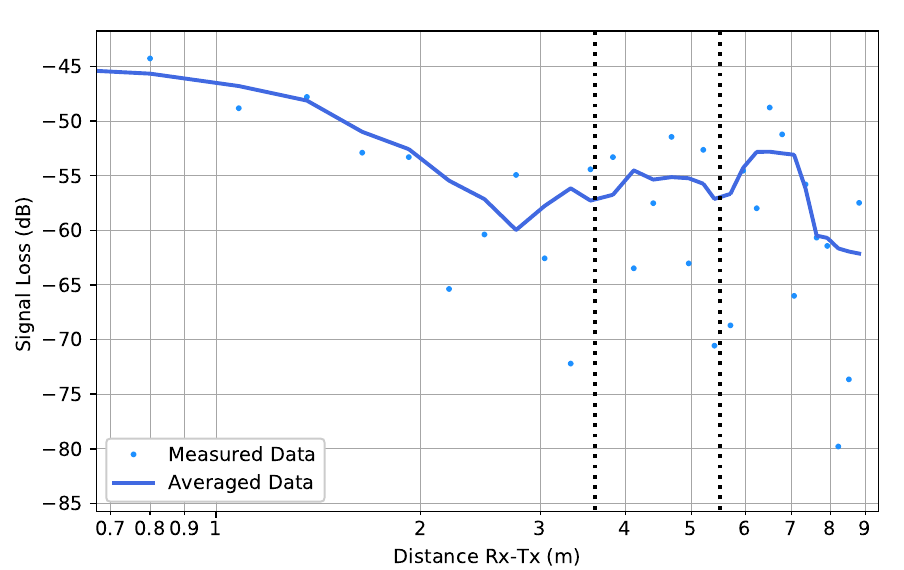
Figure 13. Scenario ST1: The measured data together with their averaged values ( solid line ) according to Equation (3). The two black dotted lines illustrate the position of the two 90 ◦ turns in the staircase.